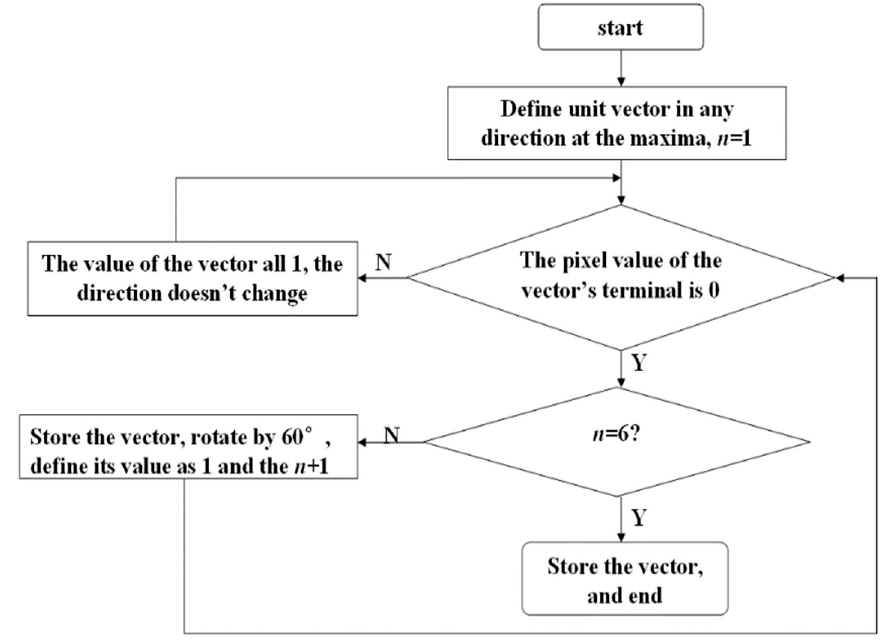
Figure 7. The flowchart of radius calculation.